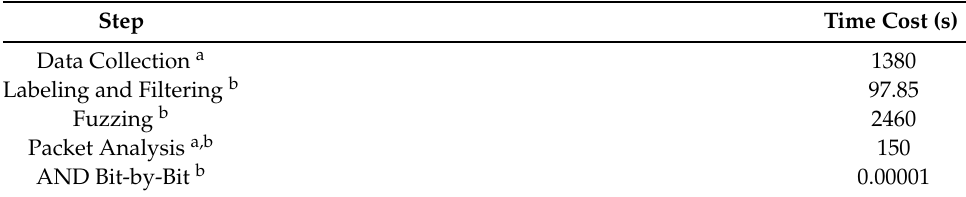
Table 5. Time consumption of the reverse